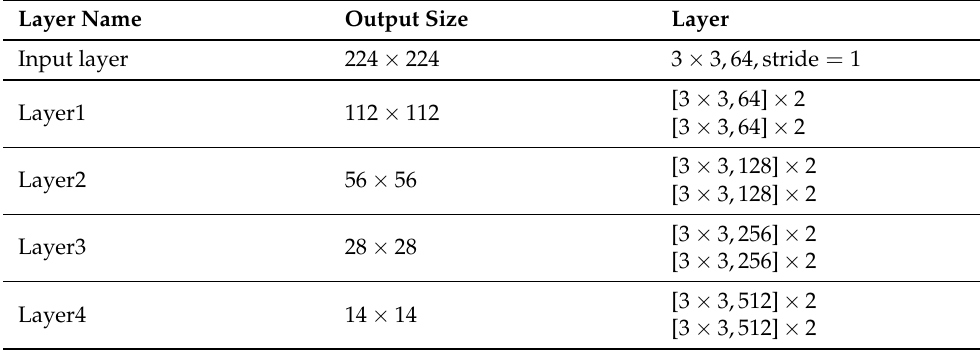
Table 3. Network structure of ResNet 18-like.